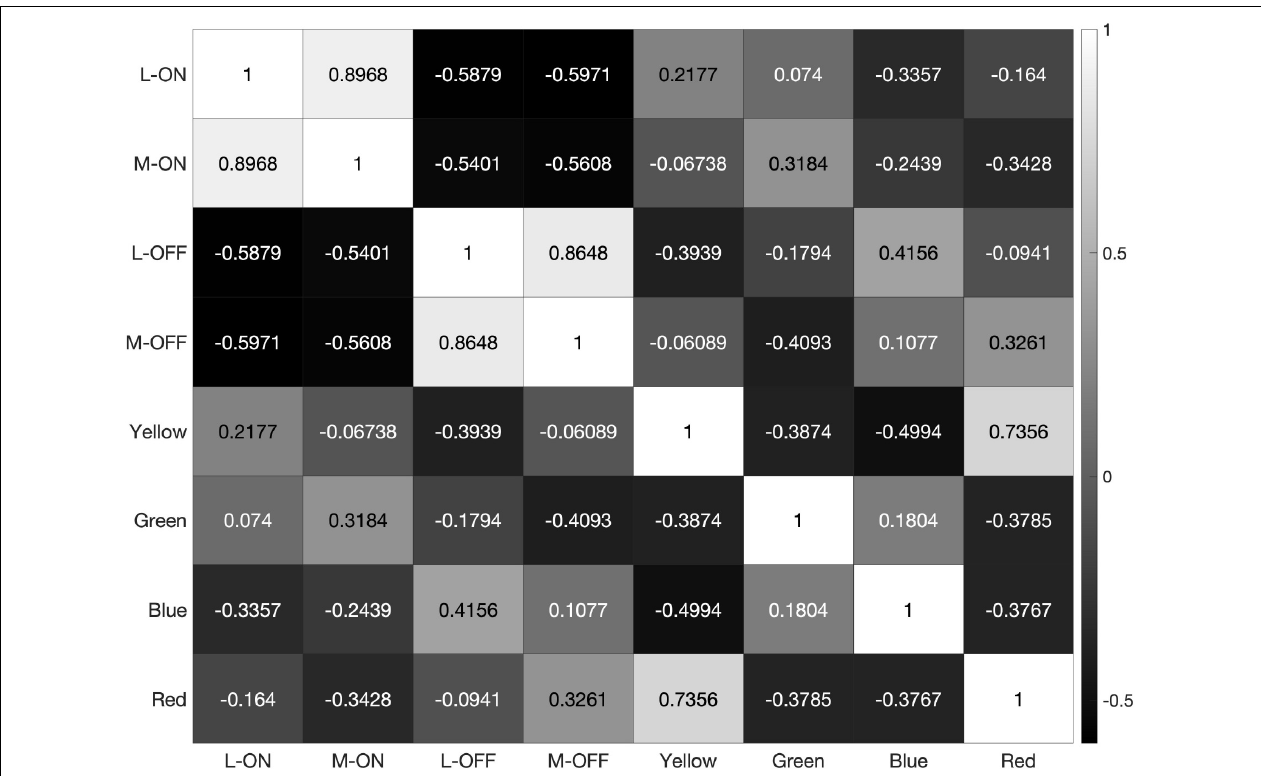
FIGURE 6 | Heatmap of correlations between the 8 receptive fields used in our model, when the model is exposed to the 21 possible edges created by combining the primary colors red, green, blue, yellow, 50% gray, white, and black.